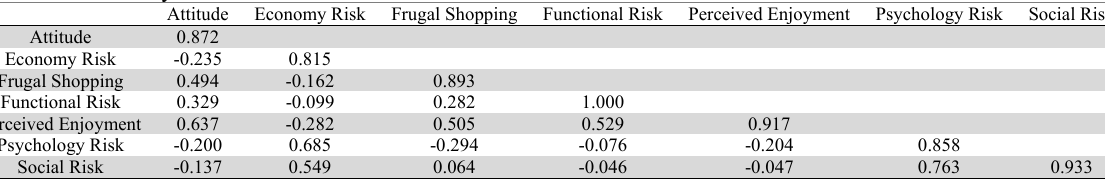
Discriminant Validity Renters